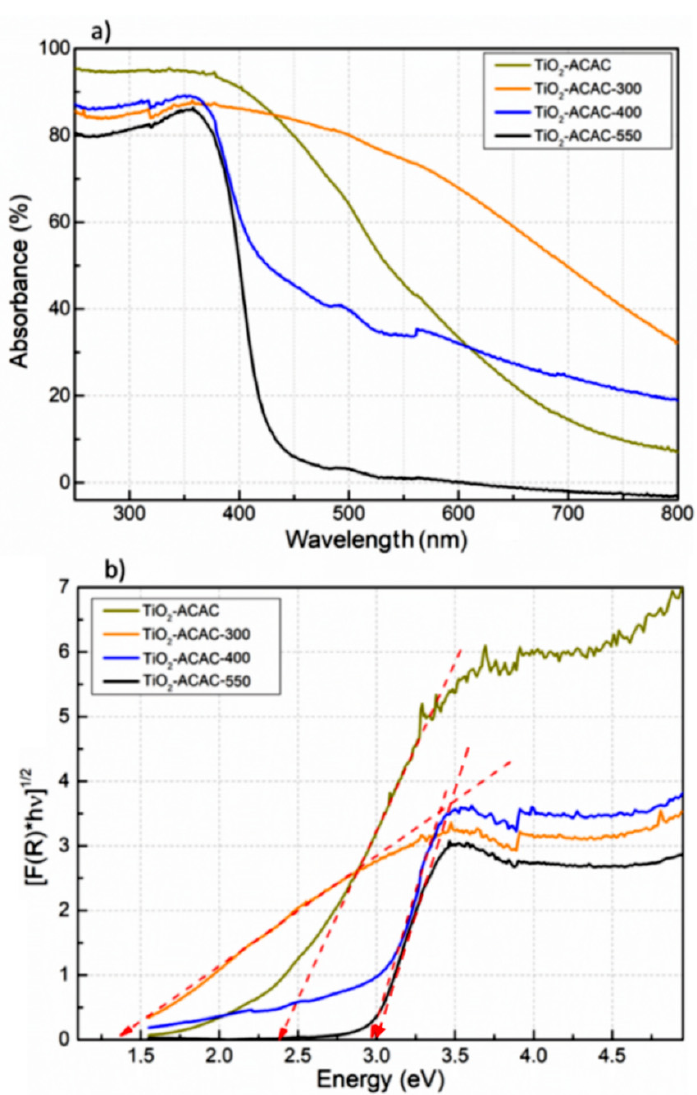
Figure 4. ( a ) DRS curves and ( b ) Kubelka-Munk plots of TiO 2 -ACAC, TiO 2 -ACAC-300, TiO 2 -ACAC-400 and TiO 2 -ACAC-550.